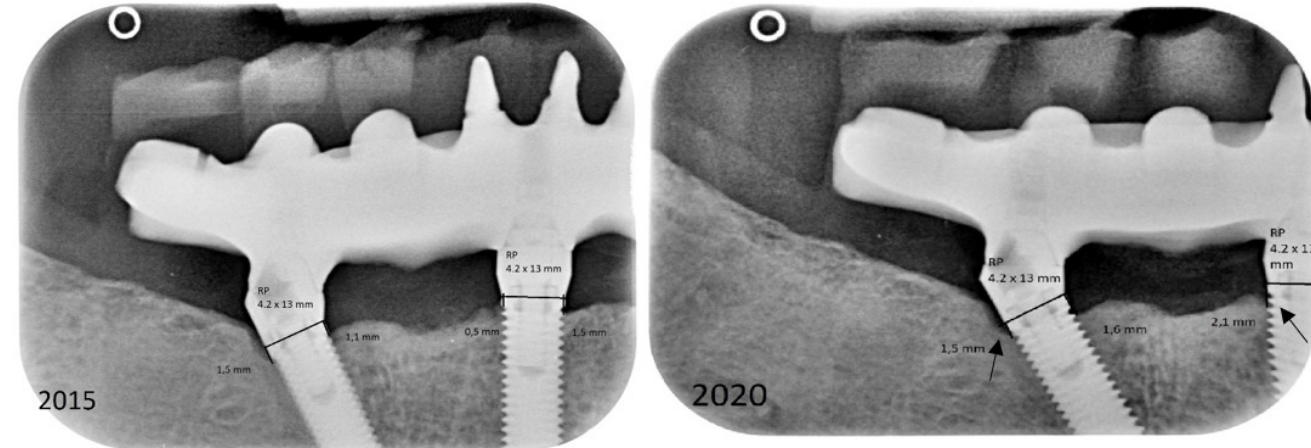
Figure 3. Example of how marginal bone loss analysis was conducted between T0 and T1. Notice the slight bone remodeling around the fixtures (arrows).